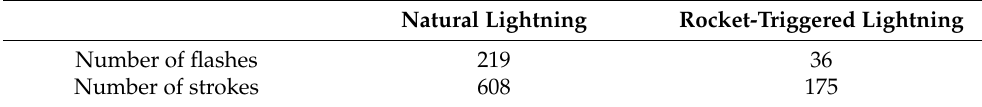
Table 1. Summary of ground-truth datasets used for the ENTLN performance